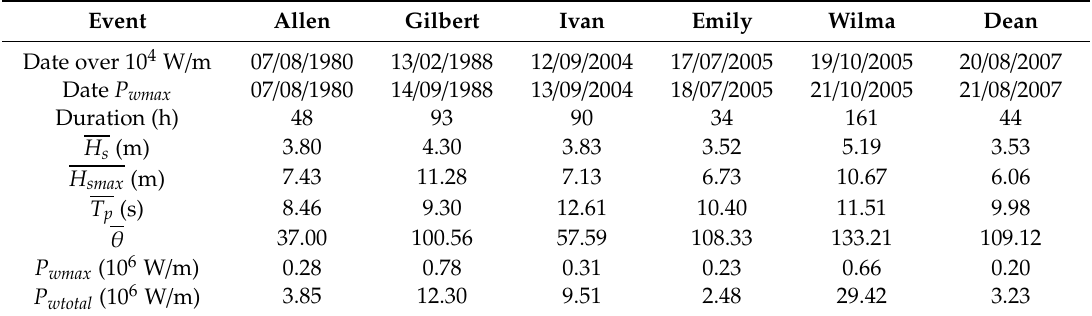
Table 1. Wave characteristics of the most extreme storm conditions induced by the hurricanes from 1979 to 2018.